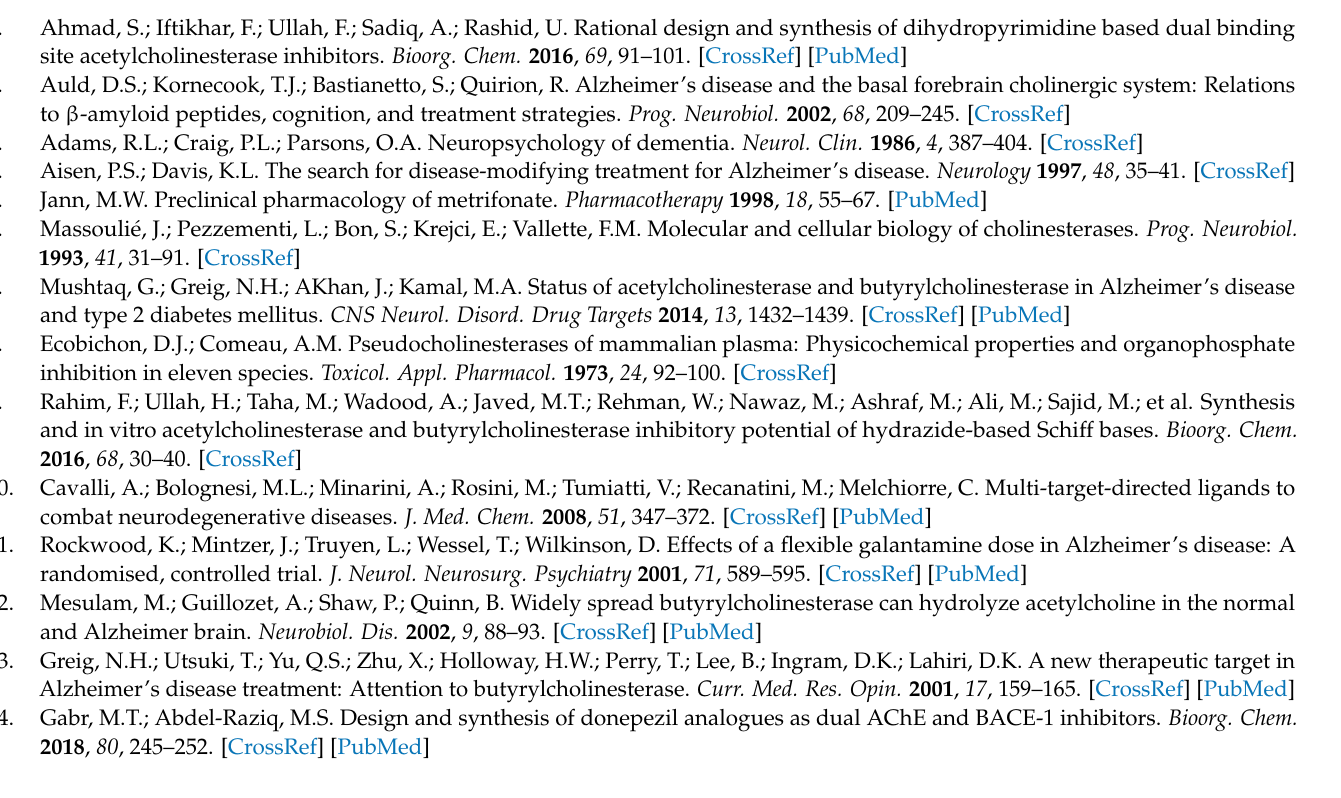
1; Figure S2: HNMR spectra of compound-11; Figure S3: HNMR spectra of compound-16